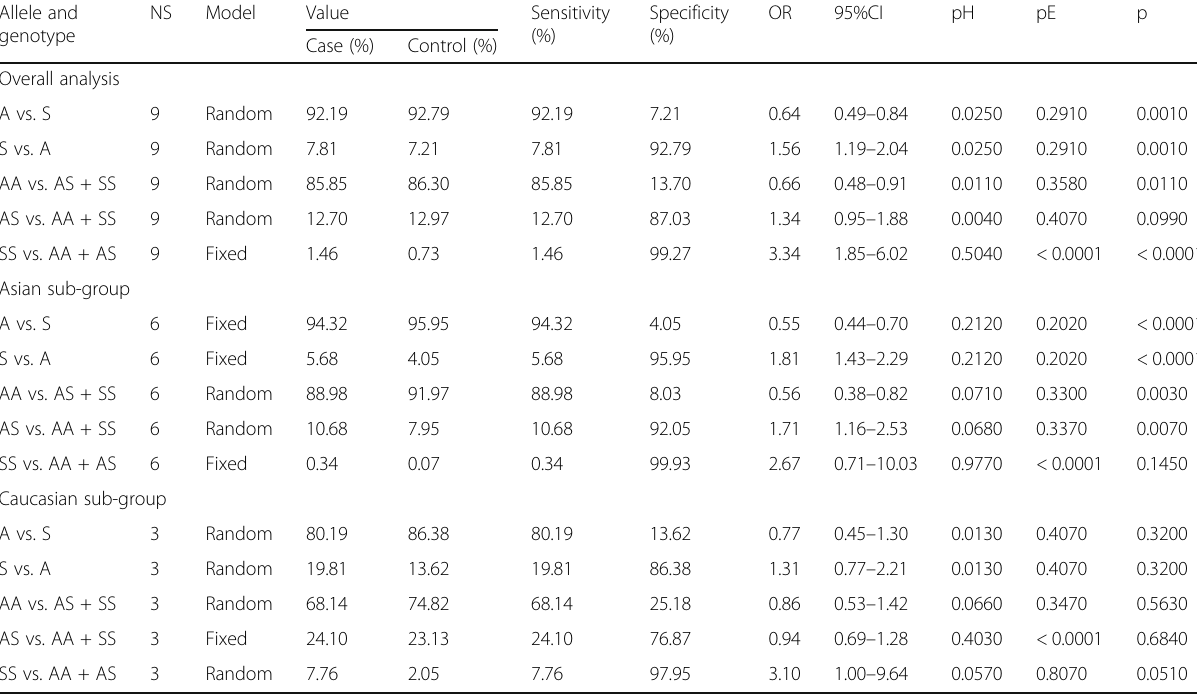
Table 5 Summary of the correlation between A986S gene polymorphism and the risk of urolithiasis Allele and genotype